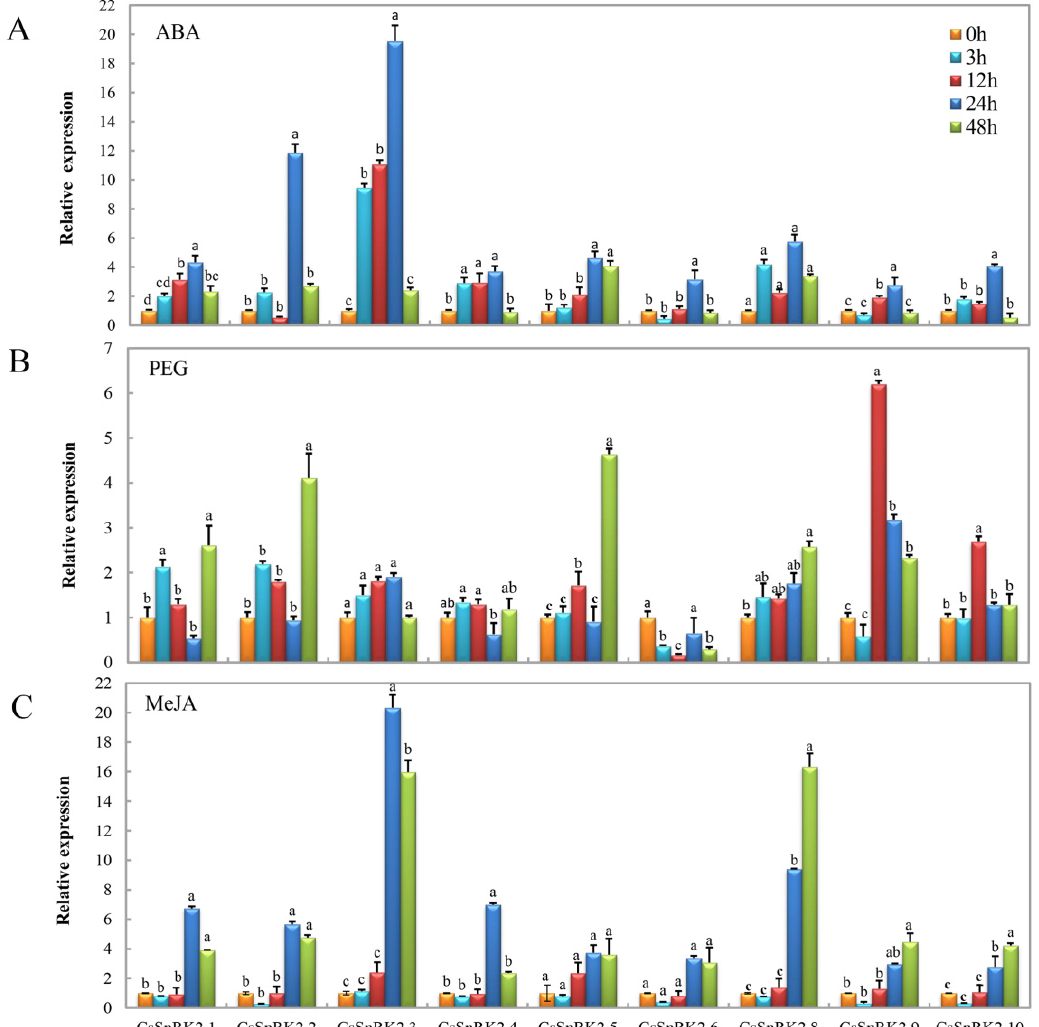
Figure 7. The expression pattern of CsSnRK genes in leaves treated with ( A ) abscisic acid (ABA), ( B ) PEG and ( C ) methyl jasmonate (MeJA). The sampling time points were 0, 3, 12, 24 and 48 h. Error bars represent the standard error (SE) of three replicates. The relative expression of each gene in different treatment is expressed as mean ± SE ( n = 3). Bars with different lowercase letters were significantly different by Duncan’s multiple range tests ( p < 0.05).